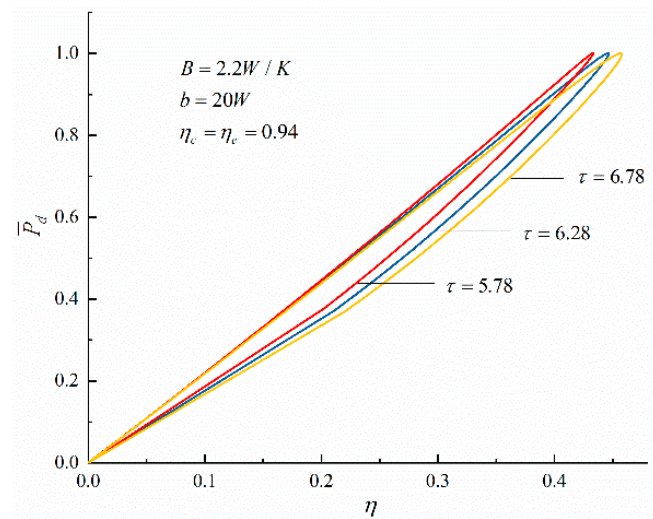
P η− about τ . Figure 3. The curves of P d − η about τ P η− about τ . d d